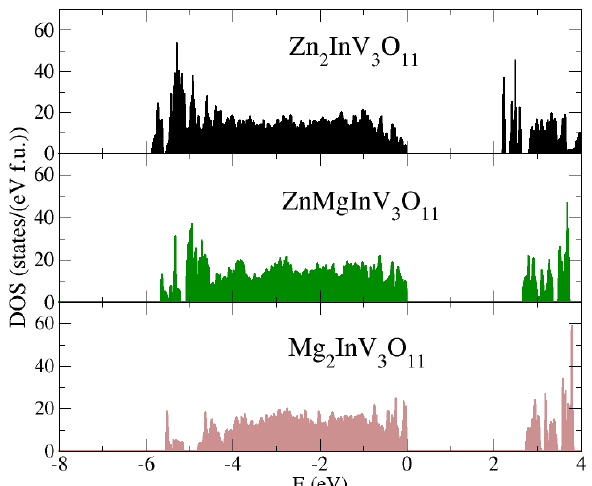
Figure 7. The total density of states (DOS) calculated for Zn 2 − x Mg x InV 3 O 11 (x = 0, 1, 2) .